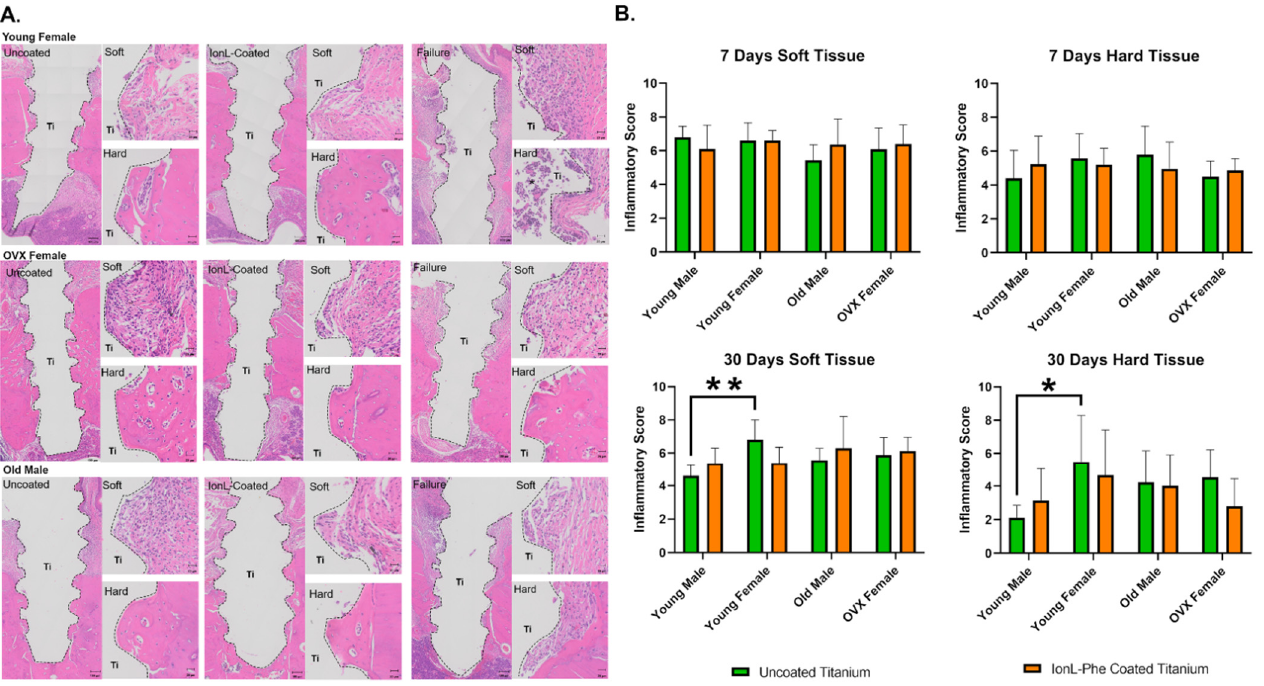
Figure 4. ( A ) Histology representing various characteristics of peri-implant healing in YF, OM, and OVXF groups, H&E panel displays the overview of peri-implant tissue in successful and failed samples, along with a more detailed view of hard and soft tissue, respectively. Ti is the void left by the implant after processing. * Indicates site of possible secondary infection. ( B ) Inflammatory scoring in all four demographic groups in IonL-Phe-coated and uncoated samples over time. * and ** indicate statistical significance among groups (* p < 0.05, ** p < 0.01).